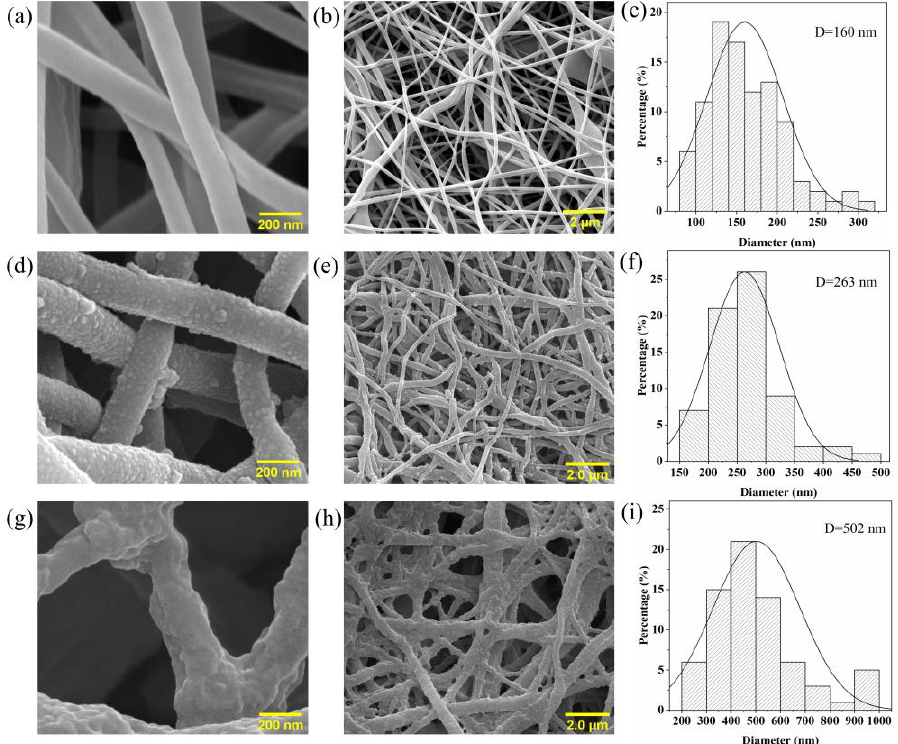
Figure 3. SEM images and nanofiber diameter distribution of ( a – c ) TPU NFMs, ( d – f ) PDA-TPU NFMs and ( g – i ) PDA/PEI-TPU NFMs.